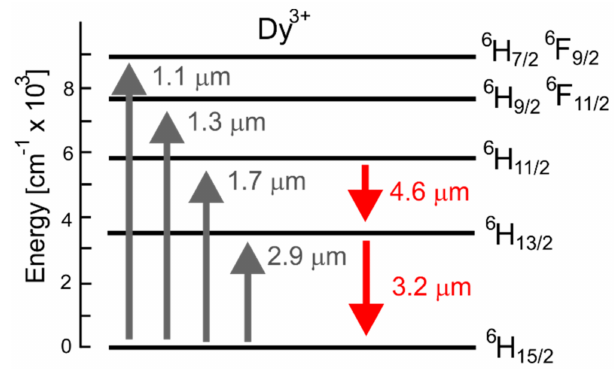
Figure 2. Energy level diagram for a dysprosium ion doped into selenide chalcogenide